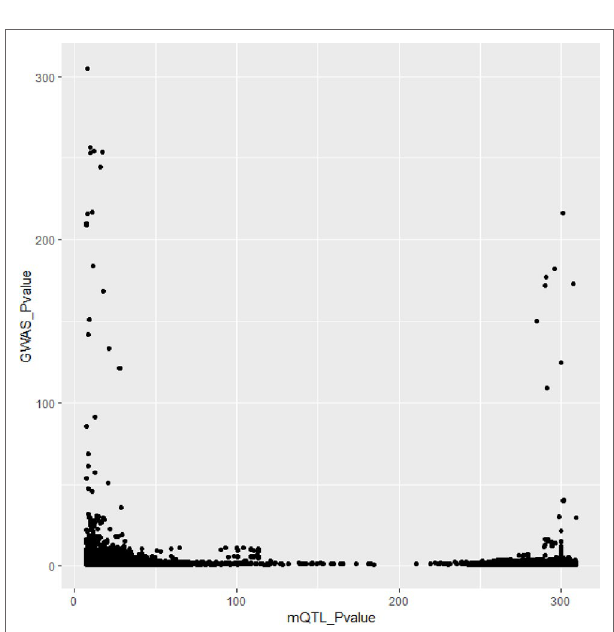
FIGURE 4 | Duplicated SNPs’ P value in genome-wide association study ( GWAS) and